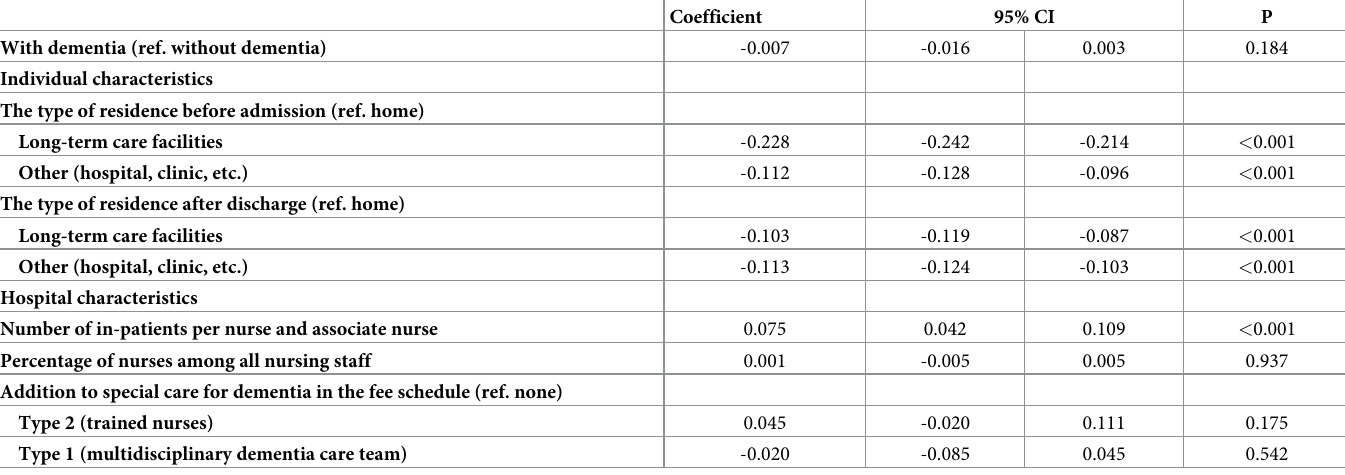
Table 5. Results of multilevel analyses for length of hospital stay (n =